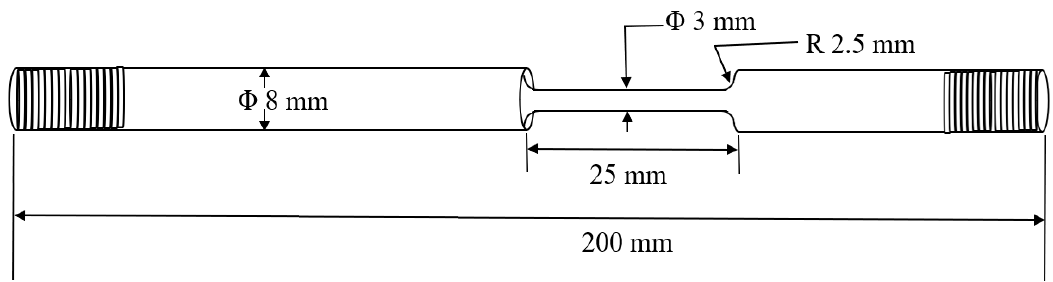
Figure 1. Schematic diagram of the tensile specimens used in the present study.